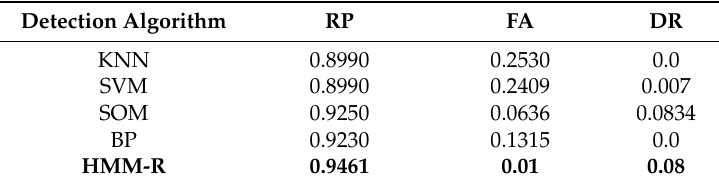
Table 2. Performance of algorithms at attack ratio of 0.01.